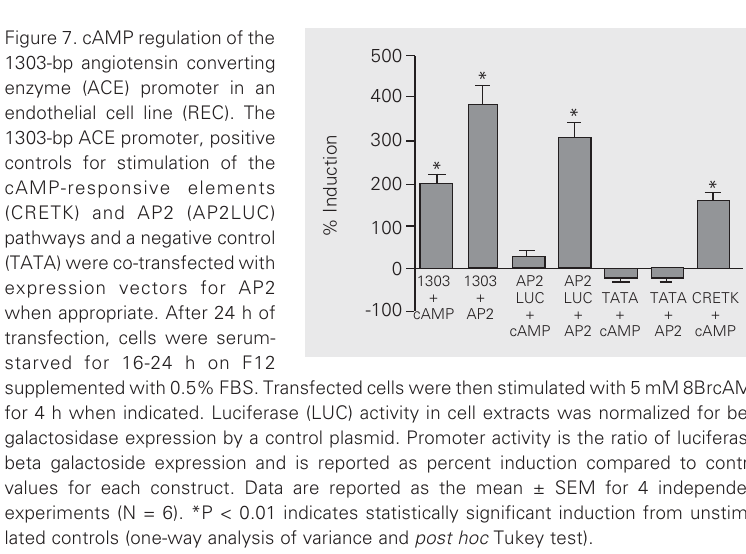
Figure 6. ATF-2 inhibits the 1303- bp angiotensin converting en- zyme (ACE) promoter in an en- dothelial cell line (REC). The 1303-bp ACE promoter was co- transfected with expression vec- tors for transcription factors ATF- 2 and c-Jun, separately or in combination. Cells were har- vested 24 h after transfection.